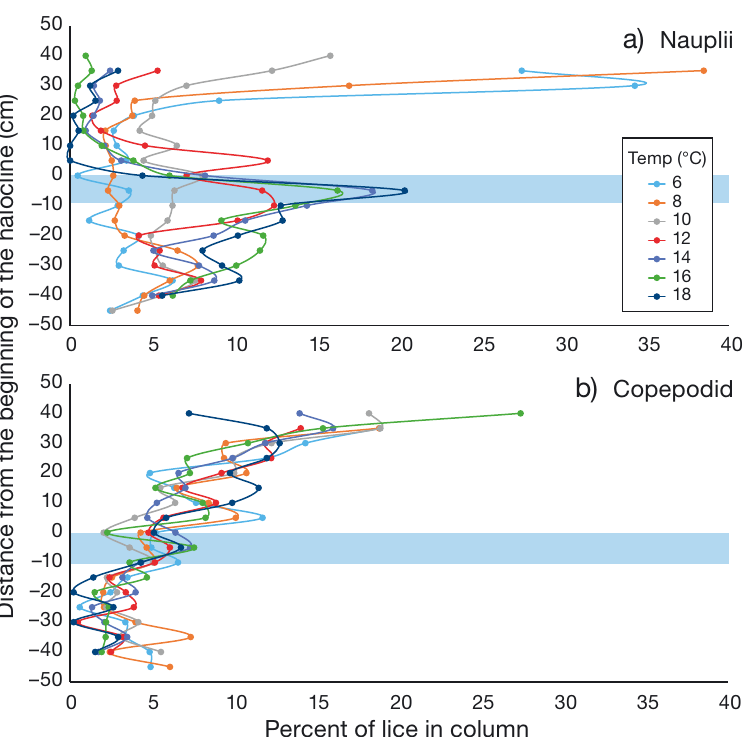
Fig. 3. Average proportion of (a) nauplii and (b) copepodids of Lepeophtheirus salmonis found in each 5 cm segment of the column relative to the thermocline for each temperature treatment. Shaded area: 10 cm over which the largest temperature change occurred. Each point represents the mean of 4 column replicates. The 12°C treatment served as an isothermal control (12°C in both the top and bottom layers of the